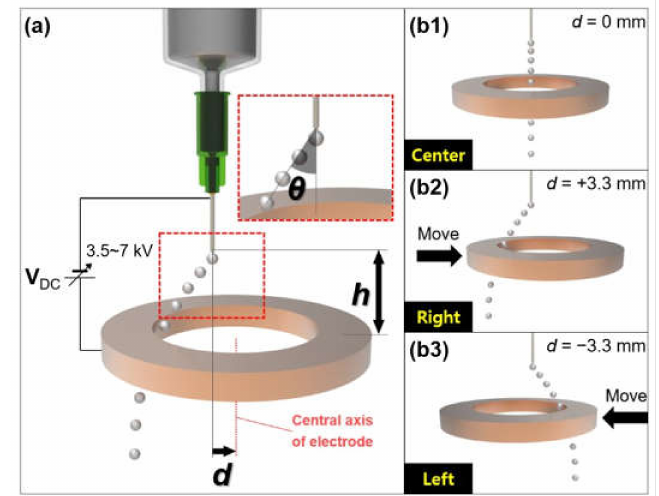
Figure 6. On-demand falling direction manipulation of the gallium-based liquid metal droplet generated by the electro-hydrodynamic method using a ring-shaped Cu electrode: ( a ) Schematic of overall system regarding direction control of liquid metal droplet; ( b1 ) falling of droplet in the center direction under d = 0 mm; ( b2 ) falling of droplet in the left direction under d = +3.3 mm; ( b3 ) falling of droplet in the right direction under d = − 3.3 mm.